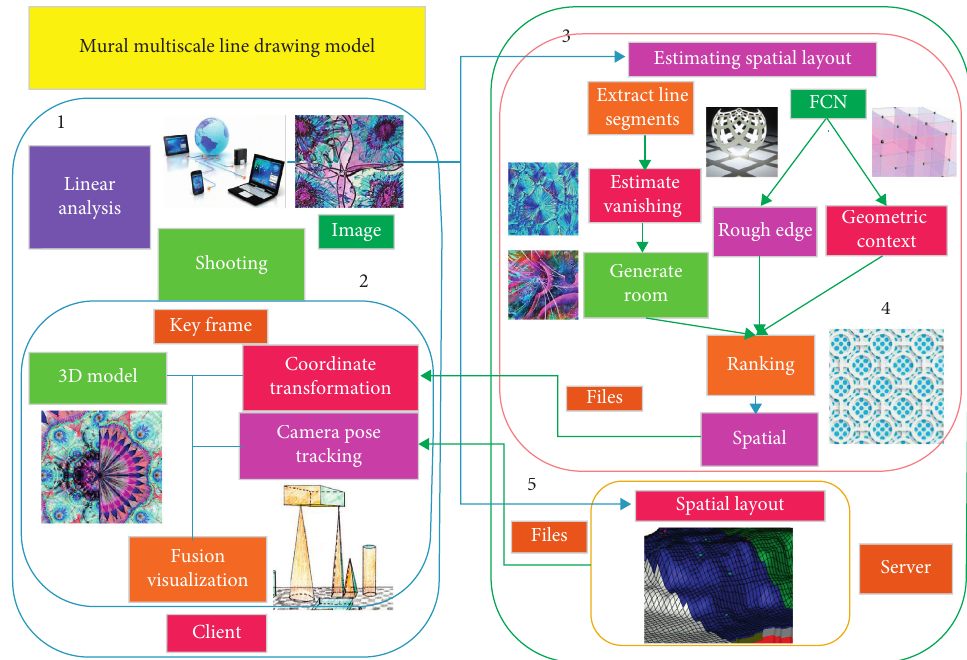
Figure 1: Mural multiscale line drawing